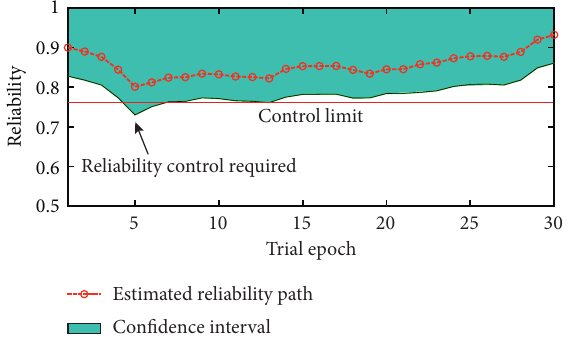
Figure 7: Illustration of reliability control